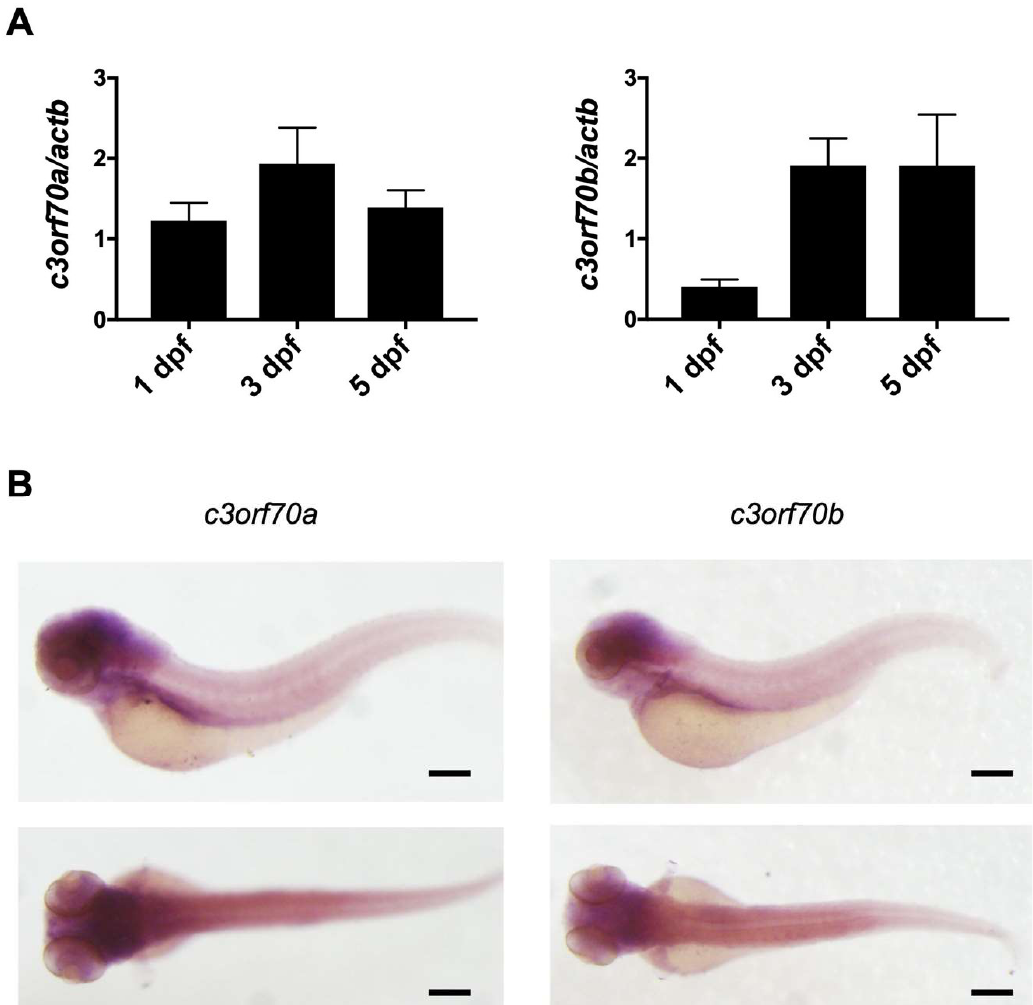
Figure 2. Expression of c3orf70a and c3orf70b in zebrafish. ( A ) qPCR analysis of c3orf70a and c3orf70b expression in zebrafish at 1, 3, and 5 dpf. Data are presented as the mean ± SEM of n = 3 relative to actb mRNA. ( B ) Whole-mount in situ hybridization of c3orf70a and c3orf70b expression in zebrafish at 3 dpf. Representative images of the lateral and dorsal views are shown. Scale bars, 200 μm.